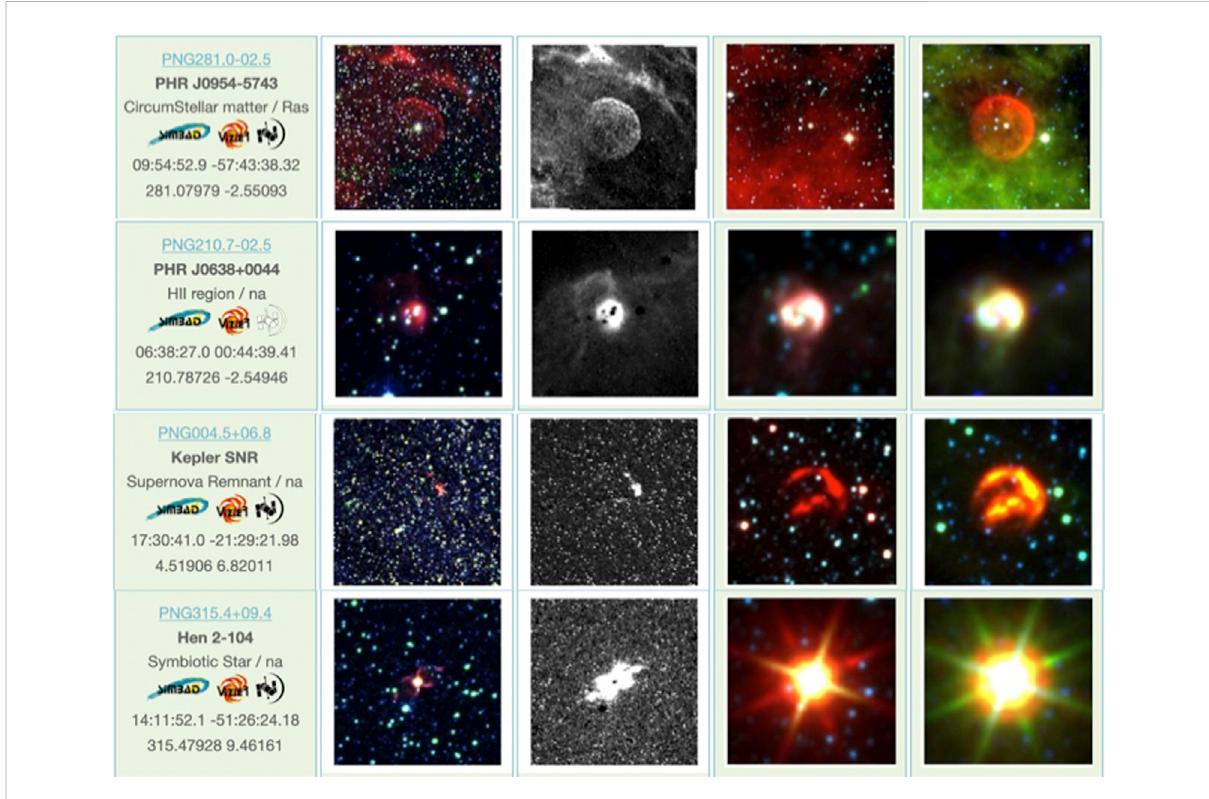
FIGURE 4 Some of the most common PN mimics. Shown from top to bottom are an example of: i) circumstellar matter; ii) a compact HII region; iii) a supernovaremnantandiv)asymbioticsystem.OnlyasmallselectionoftheavailableHASHmulti-wavelengthimageryisshown,whichis,fromleftto right, the SHS RGB and quotient images and the MIR WISE 321 and 432 RGB band